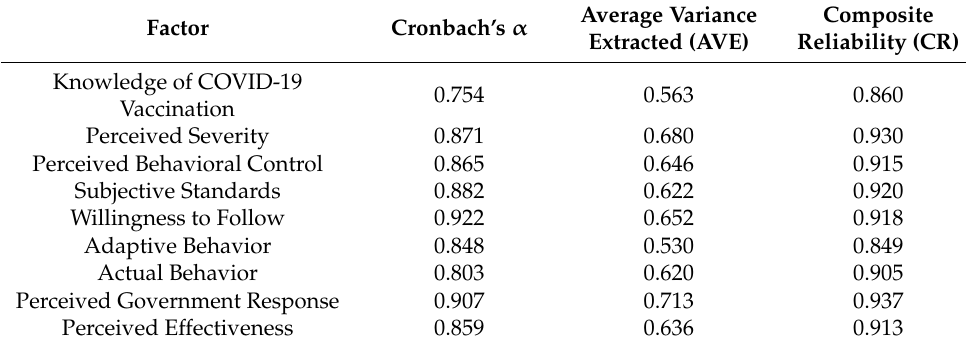
Table 4. Construct validity model.